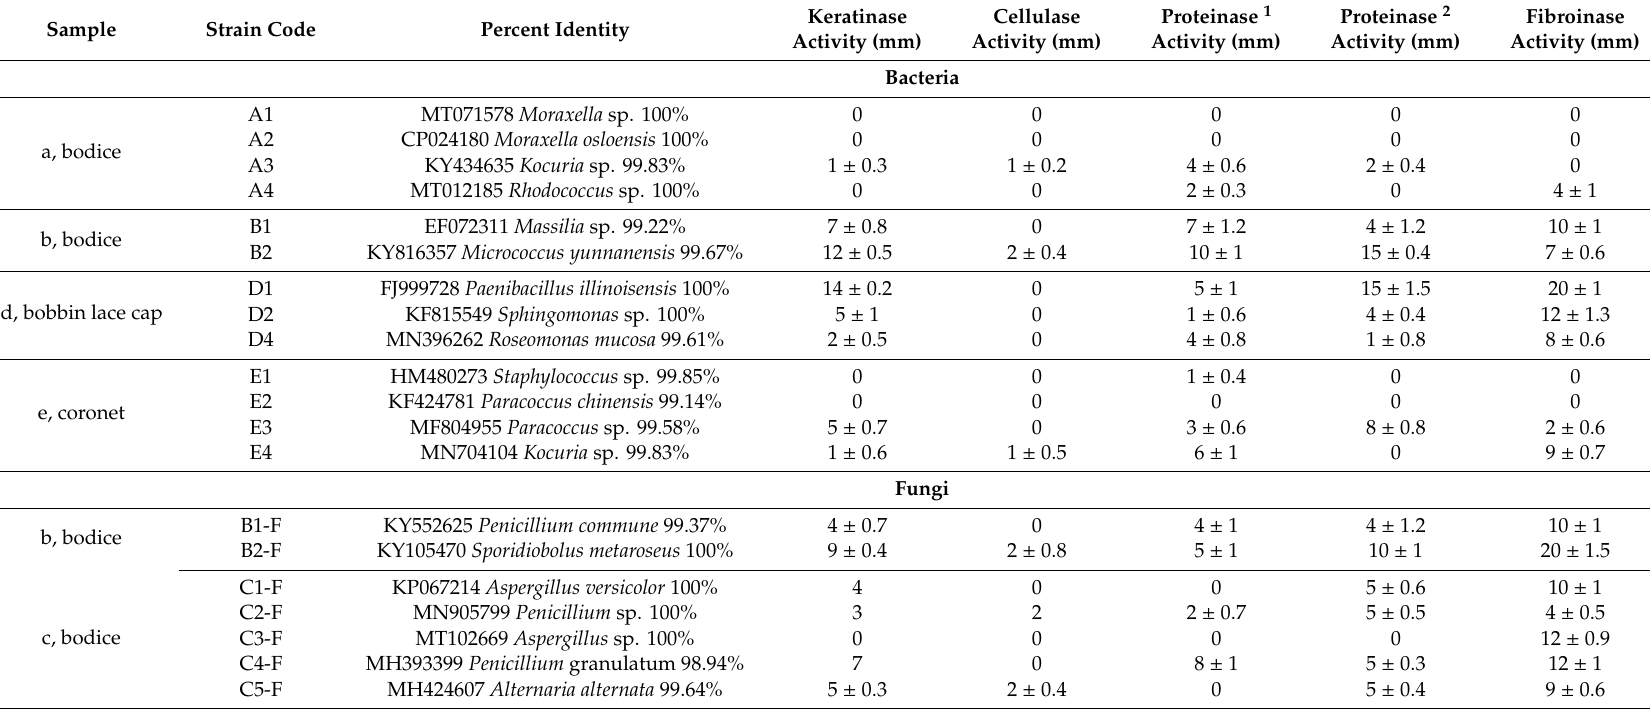
Table 1. DNA identification and hydrolytic properties of bacterial and fungal